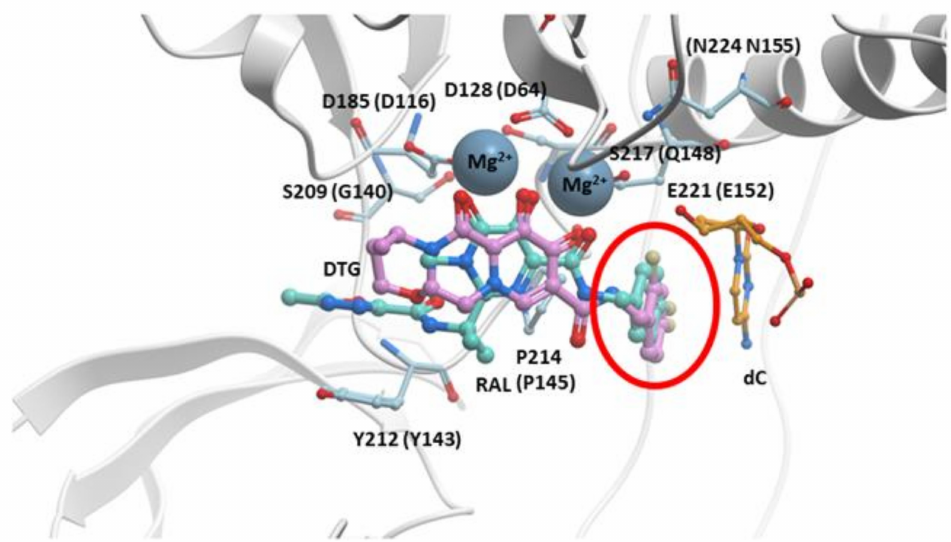
Figure 4. RAL overlaid onto DTG in the active site of the PFV intasome. The structures of both RAL (cyan) and DTG (purple) bound in the active site of the PFV intasomes [29]. IN active site residues D128, D185, and E221 are shown (the corresponding HIV-1 IN residues are given in parentheses). The penultimate cytosine near the 3 (cid:48) end of the viral DNA end is labeled and colored orange as is IN residue Y212 (shown light blue; this residue is Y143 in HIV-1 IN) where mutations conferring resistance commonly arise. The halogenated benzyl moieties are highlighted by a red circle. The terminal adenine on the 3 (cid:48) end of the viral DNA is omitted for